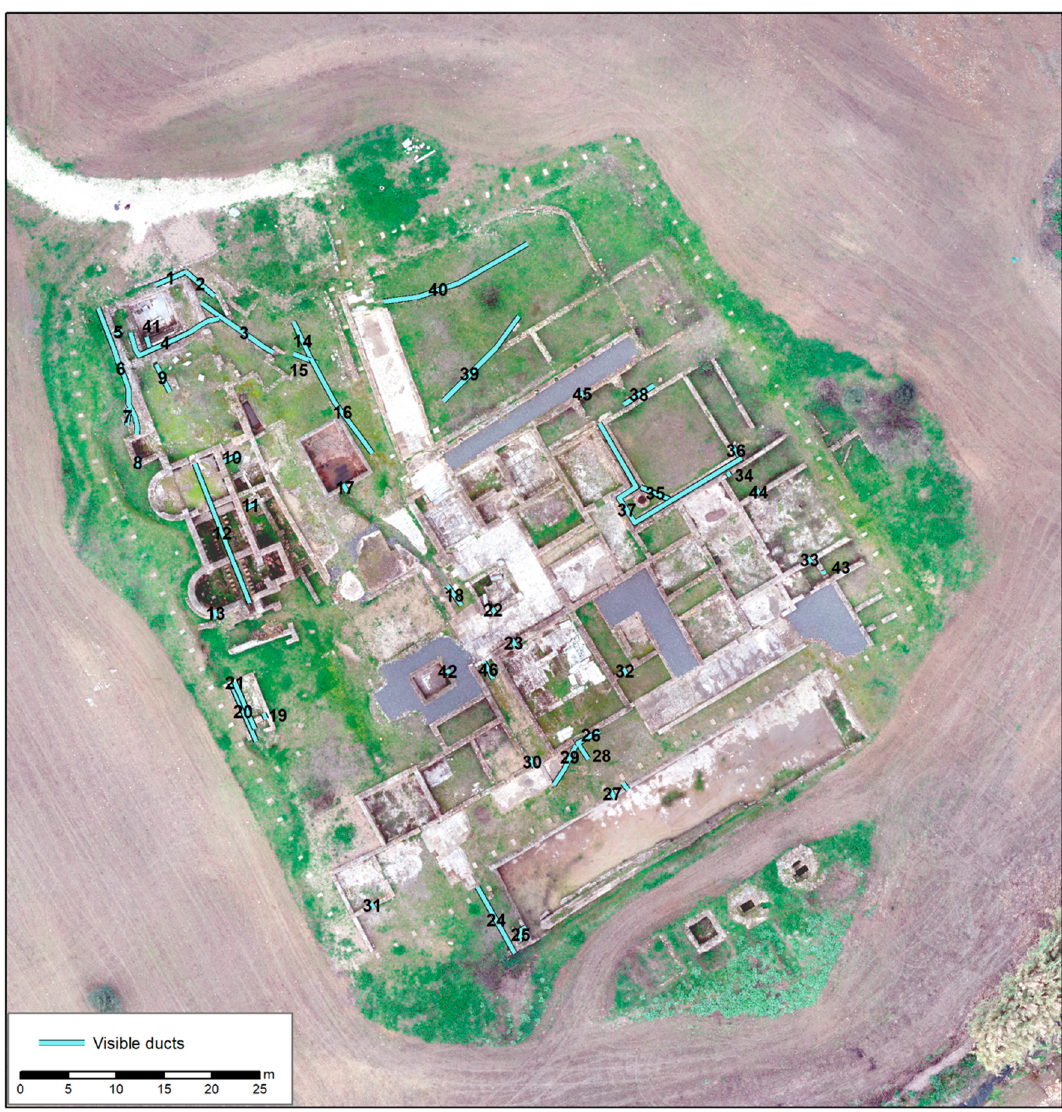
Figure 3. Location of visible water conduits in Pisões on the orthophotography of the site. Ducts 1 to 9 correspond to the original supply of the thermal building, where pipe 1 is at an elevation of 181.60 m, the highest topographical point in the whole villa. This part of the complex can be understood quite well, given that water flows from pipes 1 and 2 to 6 and from there through 3, 4, and 5 to the natatio located there, exiting at pipe 9. Ducts 10 to 13 are part of the main private therma or balneum , but only 12 and 13 correspond to the water exit of the whole system, while the other two elements are isolated and at lower levels. Ducts 14, 15, and 16 correspond to a very shallow water supply circuit that is difficult to pinpoint, as we can neither see its origin nor its end. Ducts 17 and 18 correspond to the exit of one of the large pools and a small sewer that is visible near the center of the villa, which corresponds to pipe 46. Elements 19, 20, and 21 are related to the latrines, a clean water inlet, and a sewage exit. Ducts 22 and 23 are the water exit of the central impluvium and the water inlet of one of the rooms, which, due to its marble cladding, could be a low recreational pool.